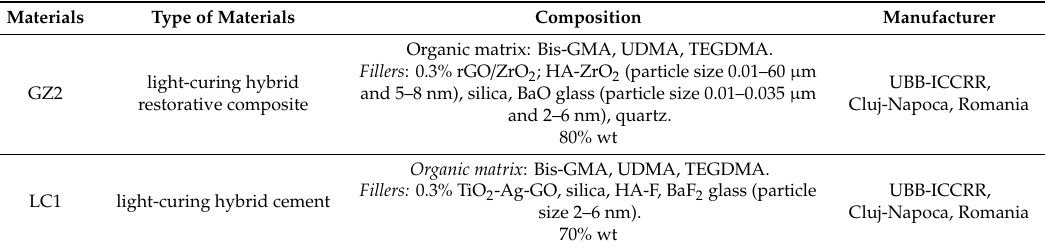
Table 1. The composition of the materials used within the